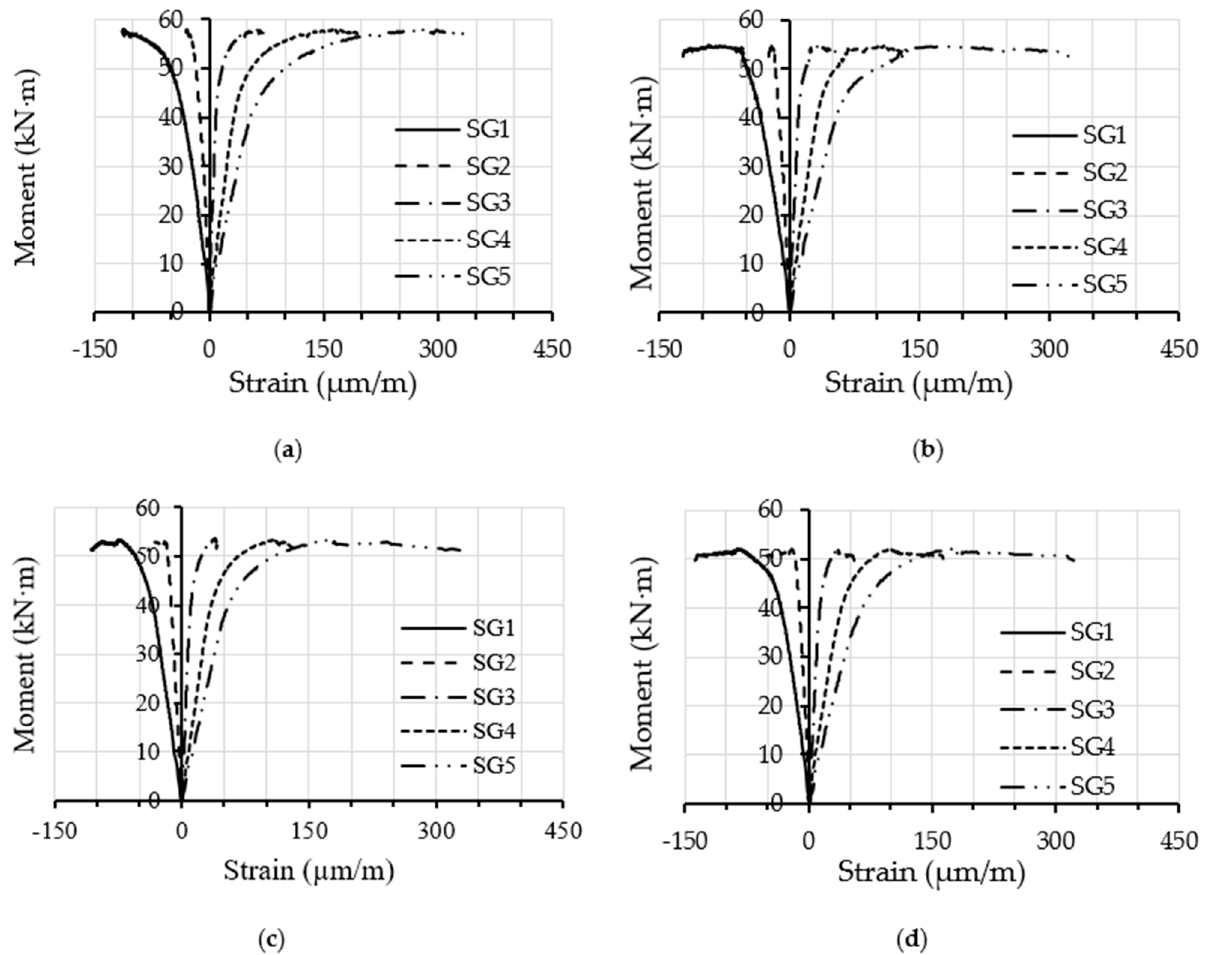
Figure 6. Moment vs. longitudinal strain relationships of the filled specimens: ( a ) FB-RC0; ( b ) FB-RC30; ( c ) FB-RC50; ( d ) FB-RC70.